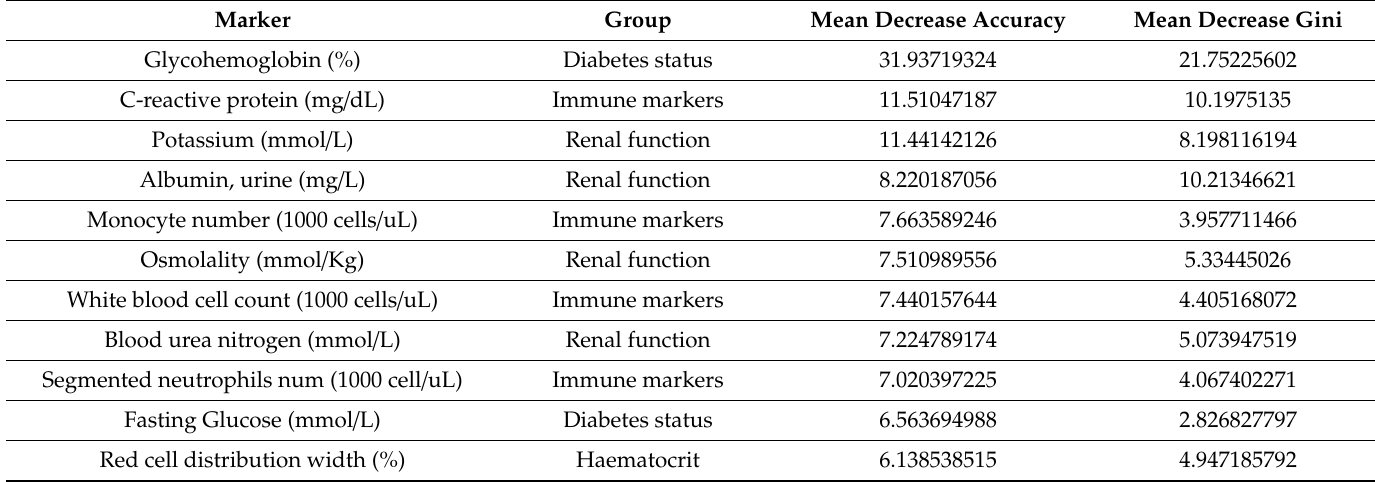
Table 4. RandomForest ™ -selected variables (features) ranked by mean decrease